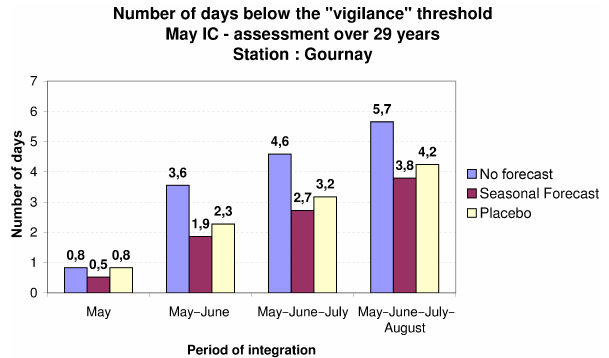
Figure 4. Evaluation of the quality of the May initial conditions forecasts. The metric is applied for four periods of integration, from 1 month (May) to 4 months (May to August). The best decisions would lead to “zero day below the